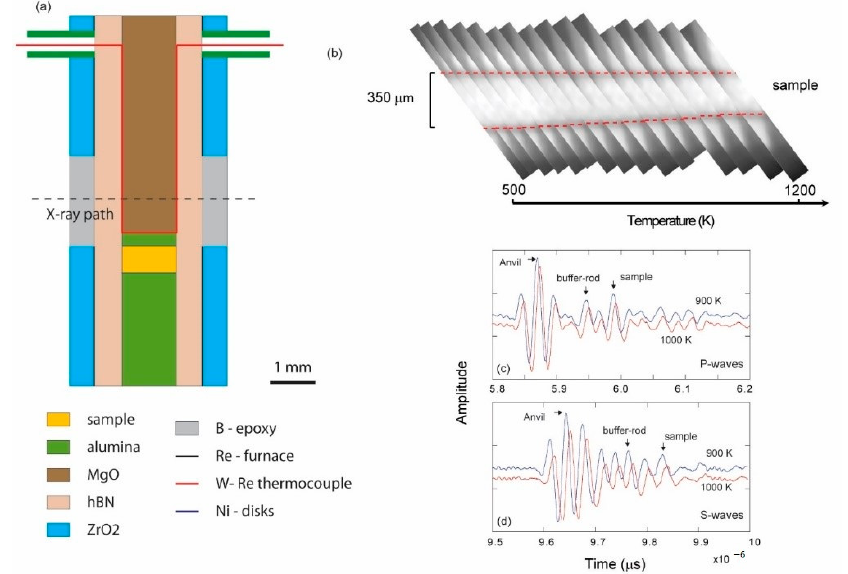
Figure 1. ( a ) Schematic assembly configuration of the multi-anvil cell assembly (before compression) used for the sound wave velocity measurements. ( b ) The stacked radiography images of the sample with increasing temperature at 3.8 GPa. The red dashed lines show the thickness of the sample. Examples of the ultrasonic signals recorded at 40 MHz for P-waves ( c ), and S-waves ( d ) recorded at 900 and 1000 K, before and after the dehydration of chlorite.